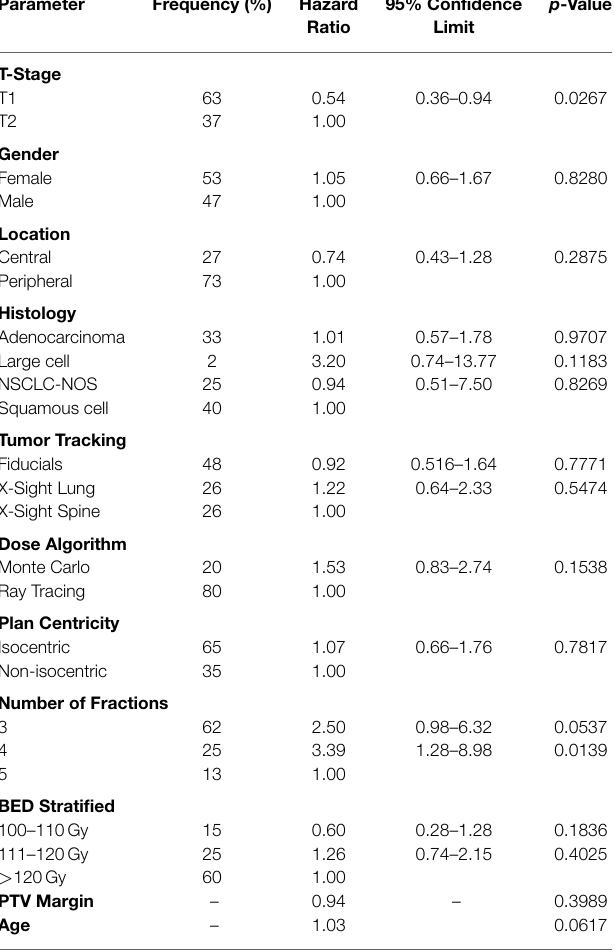
TABLE 5 | Acute and Chronic Toxicity Grading